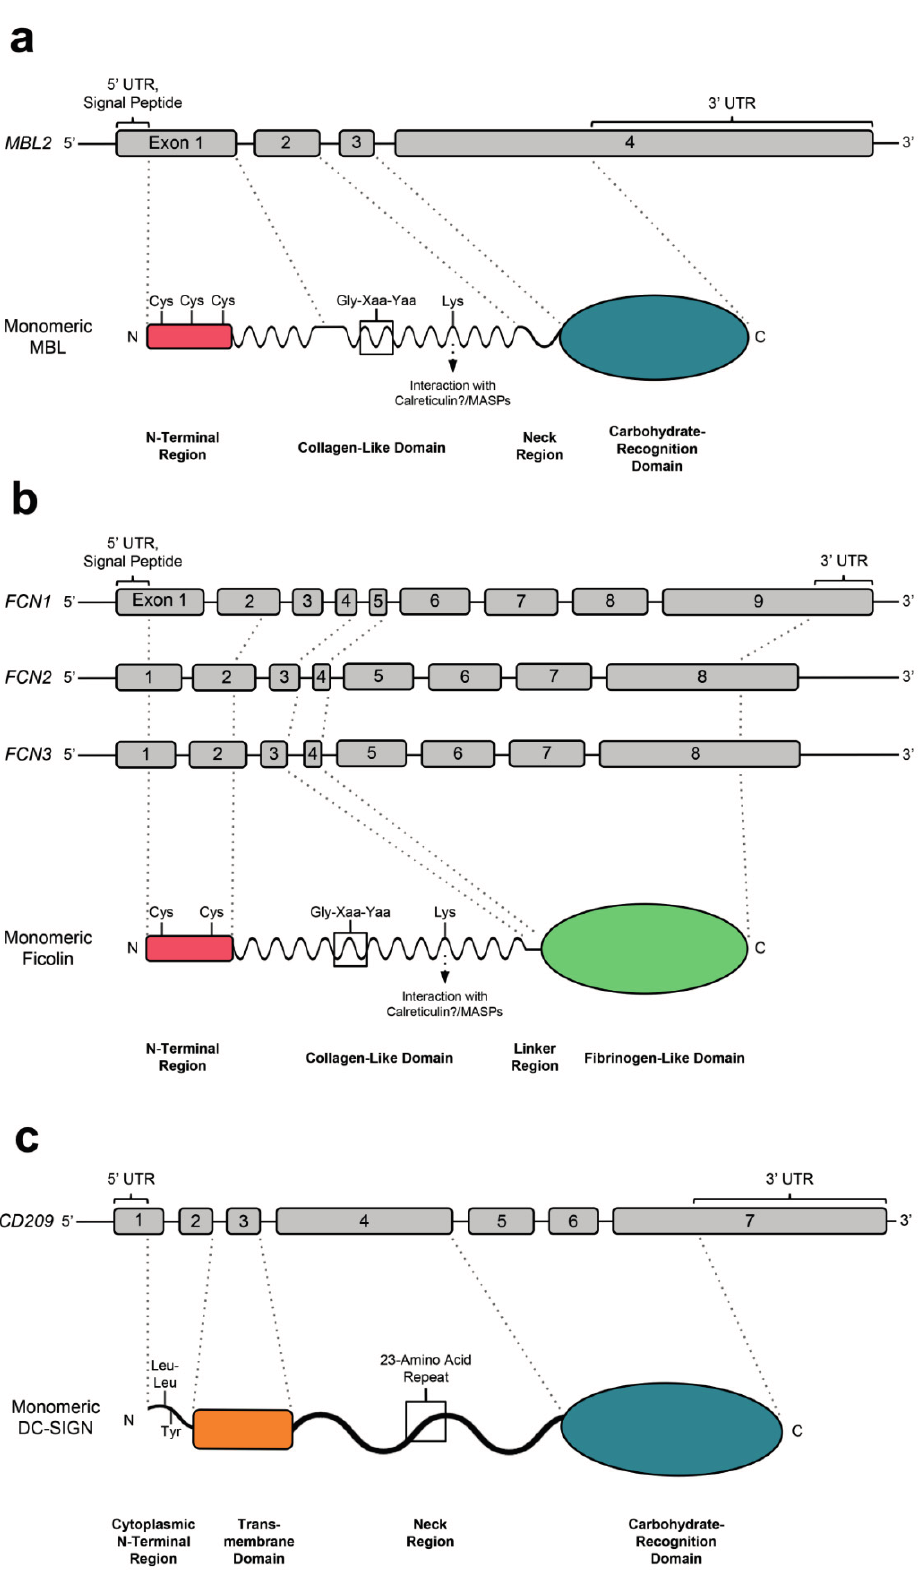
Figure 2. Exon and monomeric structures of ( a ) MBL; ( b ) ficolins; ( c ) DC-SIGN. MBL and ficolins possess 3/2 N-terminal cysteines and a lysine in its CLD, important in oligomerisation and MASP/phagocyte interaction respectively. DC-SIGN contains N-terminal, cytoplasmic dileucine and tyrosine internalisation